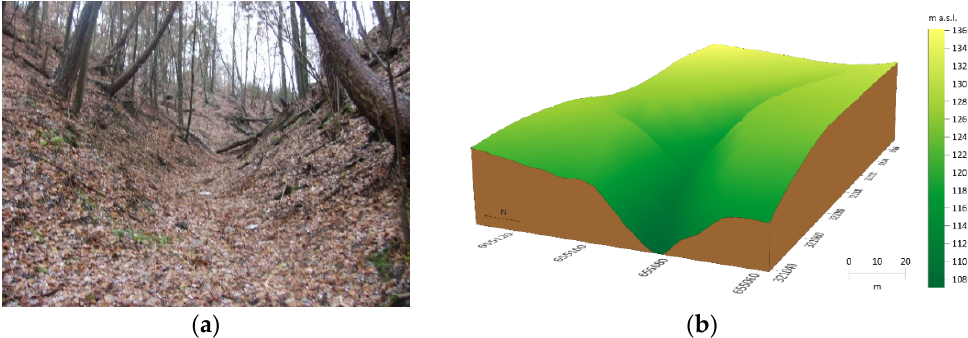
Figure 2. An example of an erosion-denudation valley (Koprzywno test area, valley no. 16): ( a ) Field photo of the valley; ( b ) Digital elevation model of the valley based on the field measurements.